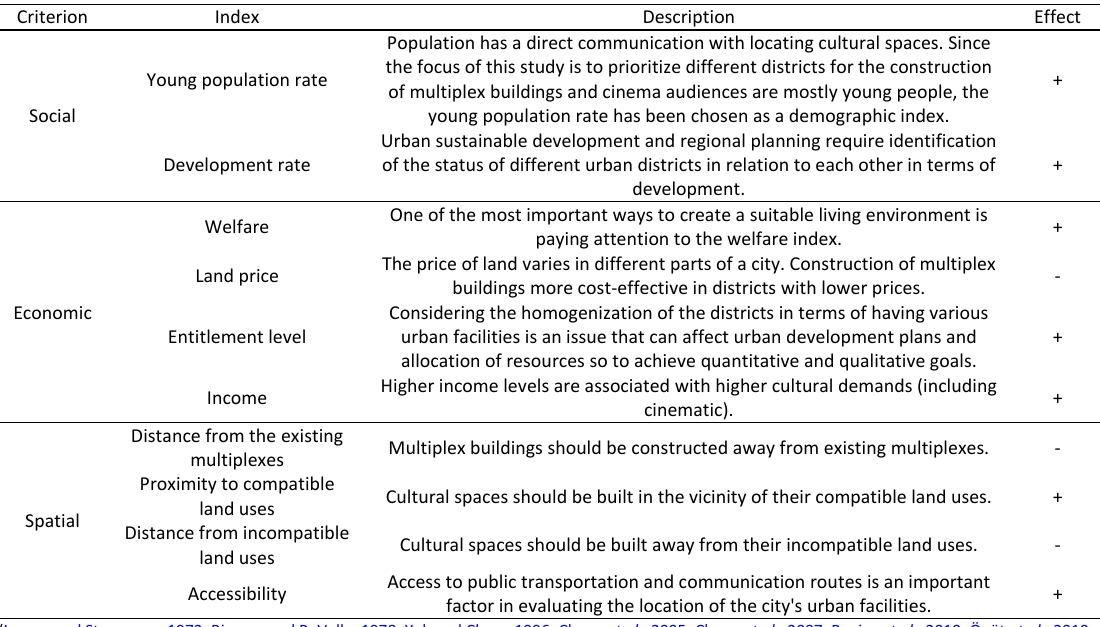
Table 2: Criteria and indices for prioritizing 22 districts of Tehran for the construction of multiplex buildings Criterion